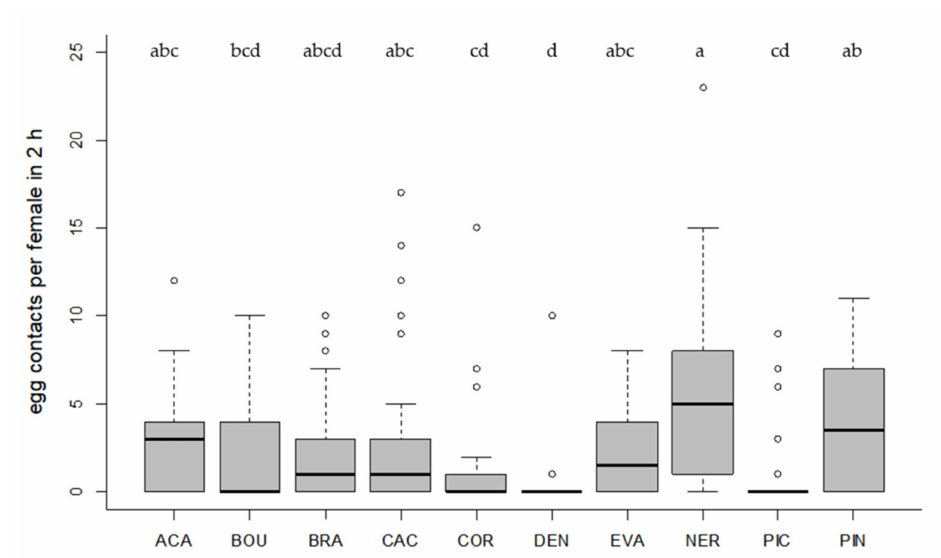
Figure 1. Number of contacts per parasitoid female with T. absoluta eggs in 2 h (24 observations / female in total). Box plots denote median (solid line), whiskers show range of data, and circles represent outliers. Di ff erent letters indicate significant di ff erences between Trichogramma strains ( p < 0.05, n = 30 females per strain).